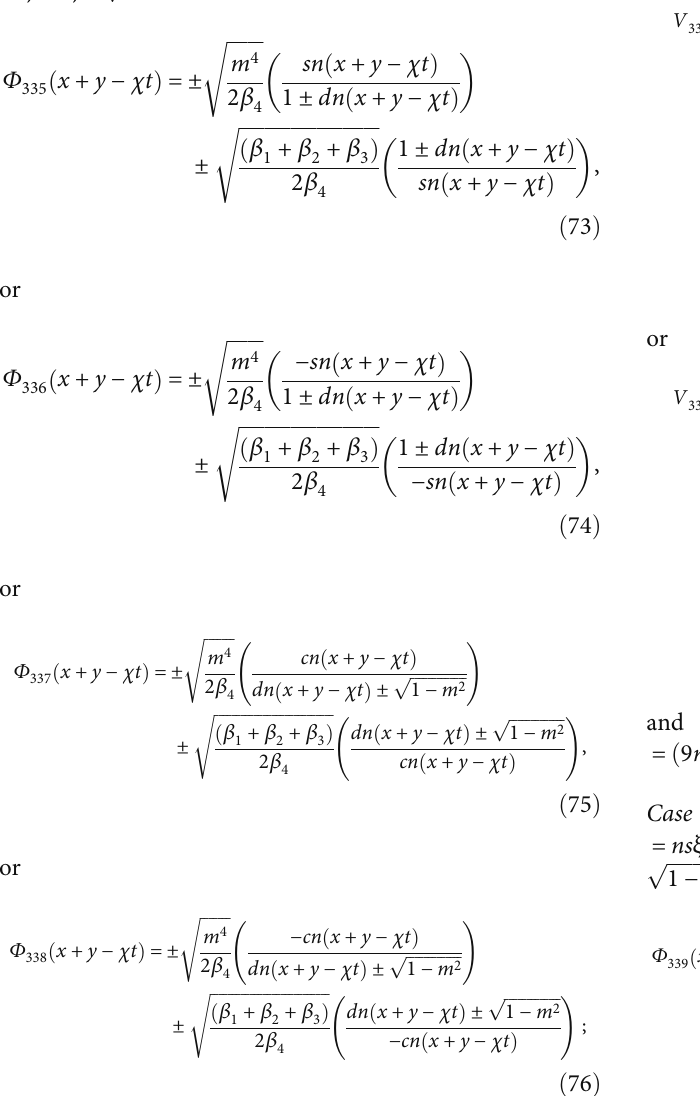
ffiffiffiffiffiffiffiffiffiffiffiffiffi p 1 − m 2 Þ ±